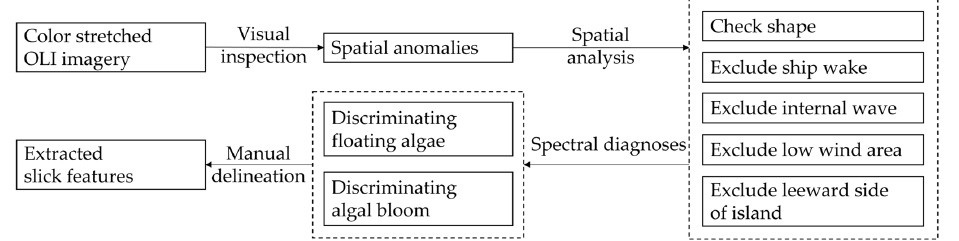
Figure 2. Flowchart of oil slick feature extraction procedures.